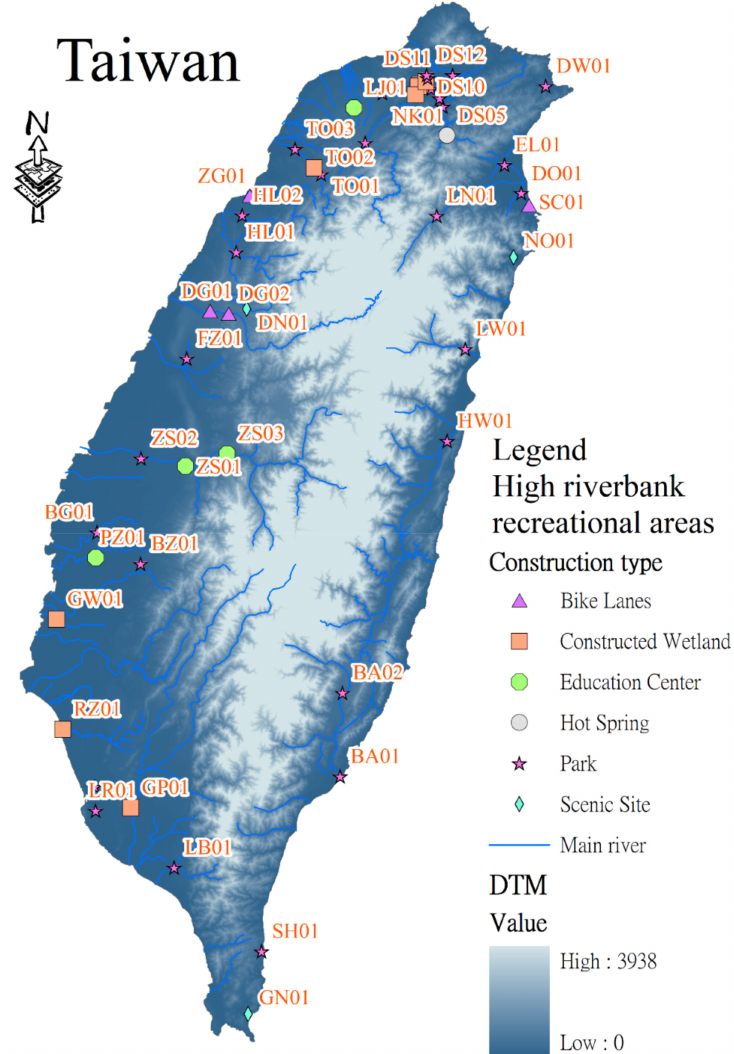
Figure 1. Distribution of investigation